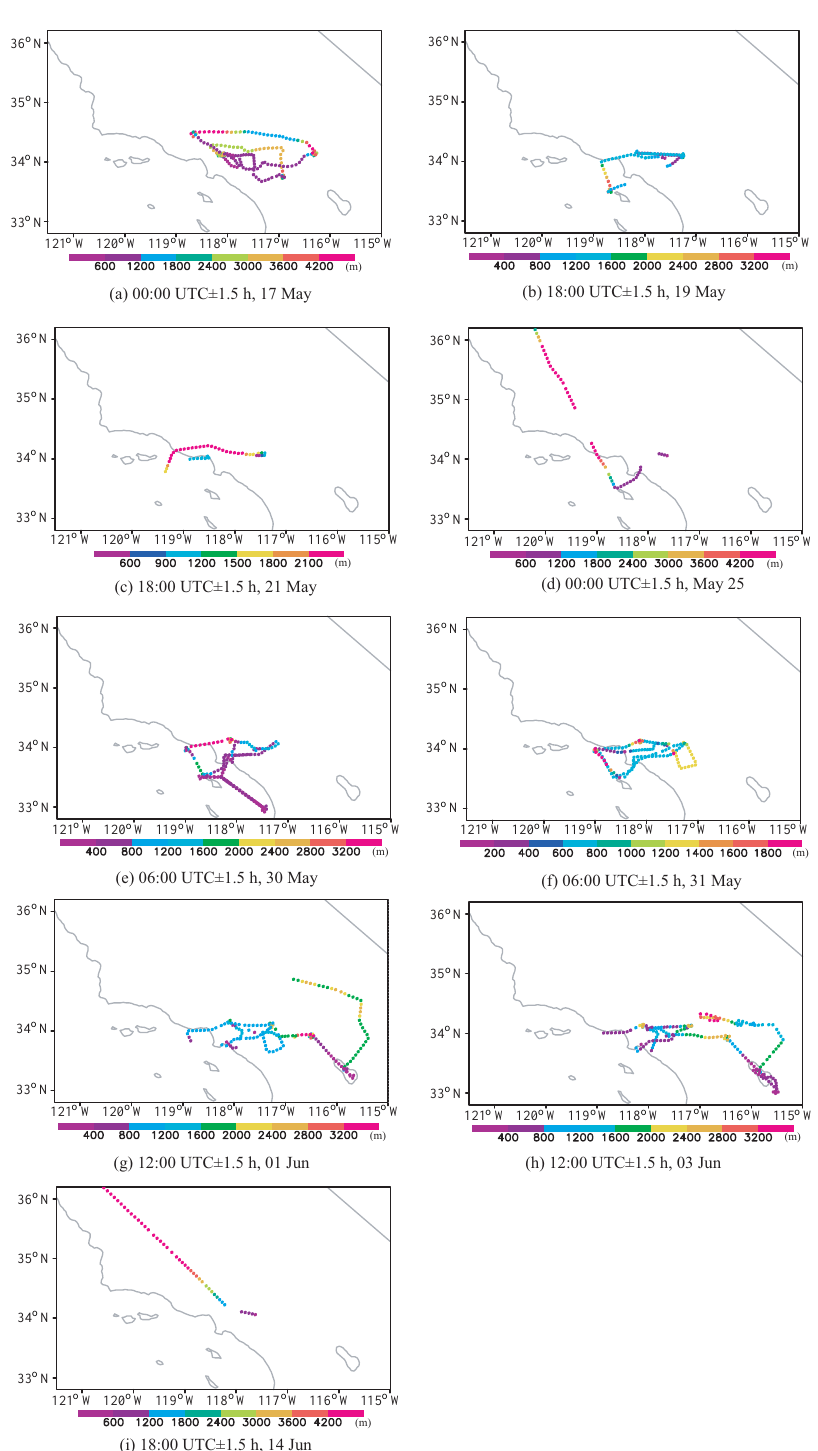
Figure 8. Aircraft flight tracks during the time window of data assimilation for nine cases. The color of the track indicates the aircraft height.